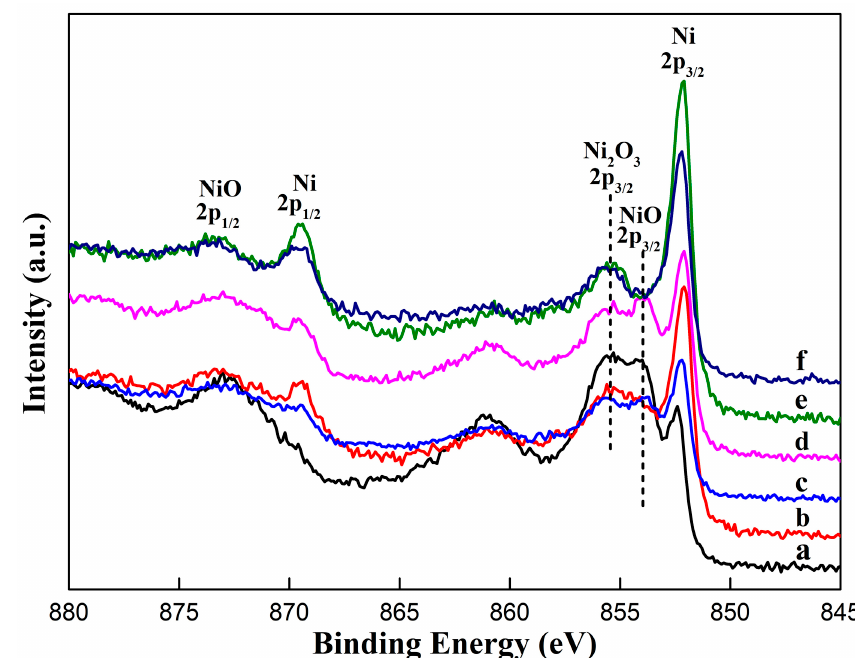
Figure 5. Ni 2p XPS spectra of Ni surfaces: ( a ) untreated; ( b ) etched by HCl; ( c ) etched by H 2 SO 4 ; ( d ) etched by H 3 PO 4 ; ( e ) etched by HNO 3 ; and ( f ) etched by HF.